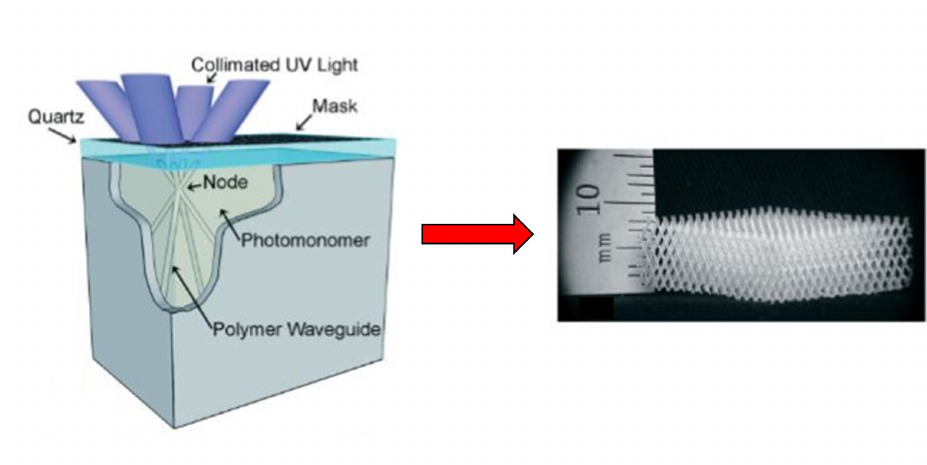
Figure 21. Operational scheme of the self-propagating polymer waveguide (SPPW) technique. Reprinted with permission from Ref. [138]. Copyright 2007,